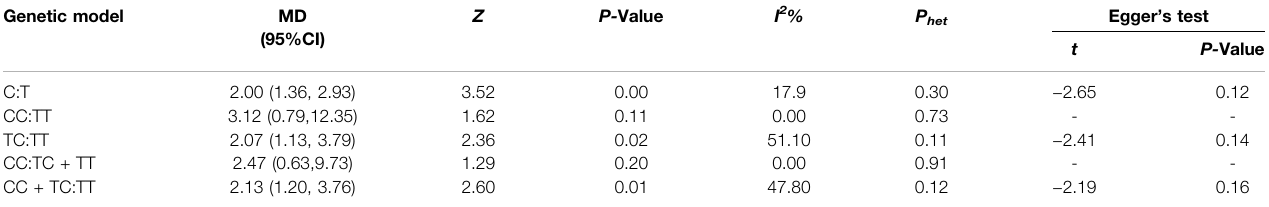
TABLE 2 | Results of the meta-analysis. Genetic model